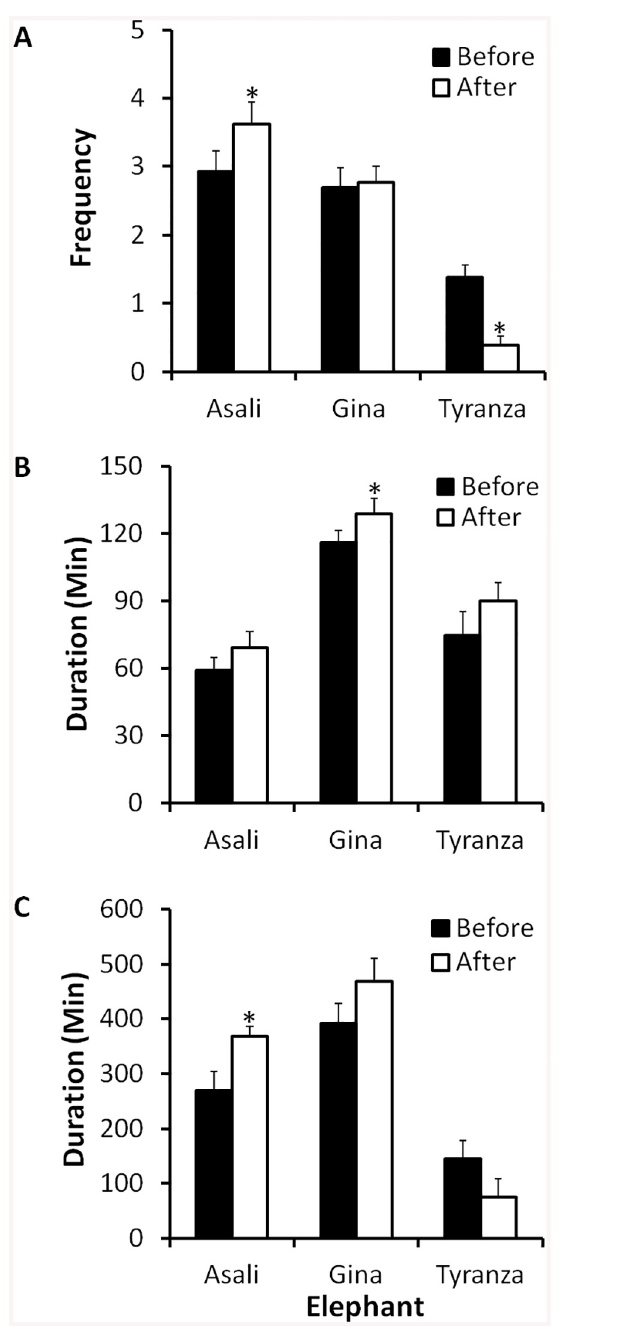
Fig 5. Mean ± SE of (A) frequency of sleeping ( ‘ lying rest ’ ) events per night; (B) duration of events; and (C) duration between the first and last events each night before and after renovations. An asterisk ( * ) indicates that the mean for after renovations is outside the 95% CI for the data before